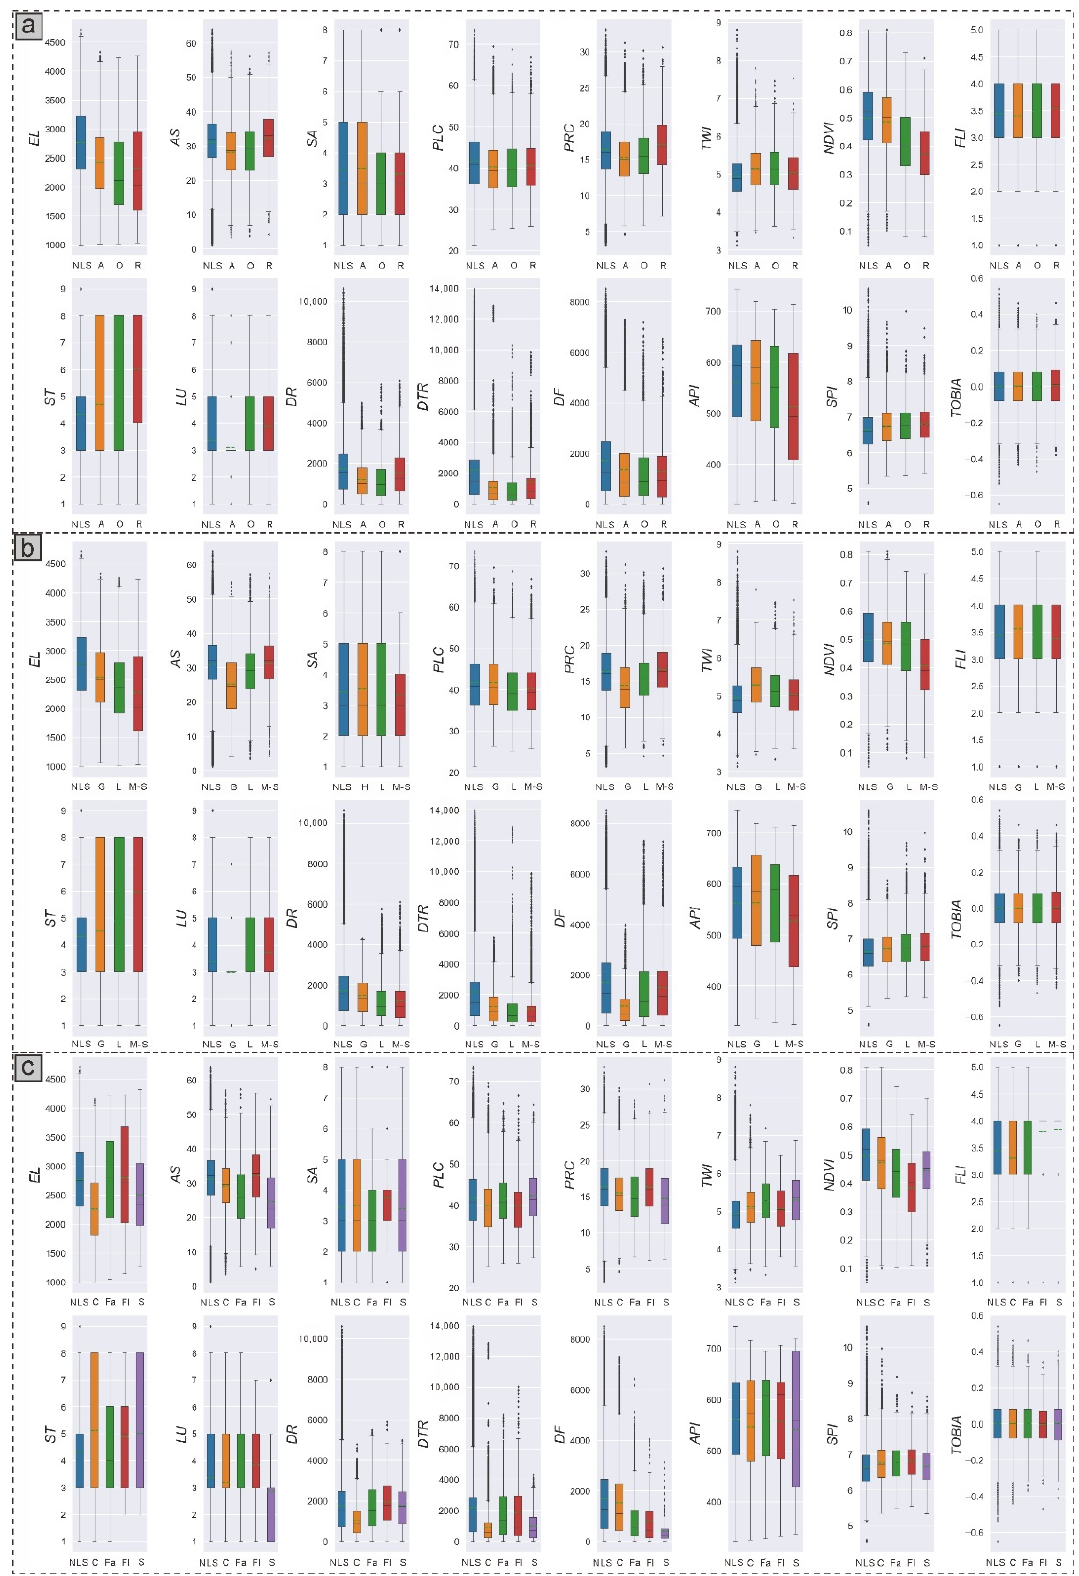
Figure 10. Box plots of correlation factors for the three classification datasets. ( a ) Classification by relative age. NLS non-landslides, A ancient landslide, O old landslide, R recent landslide. ( b ) Classification by size. NLS non-landslides, G giant landslide, L large landslide, M-S mid-small landslide. ( c ) Classification by type of movement. NLS non-landslides, C complex landslide, Fa fall, Fl flow, S slide.